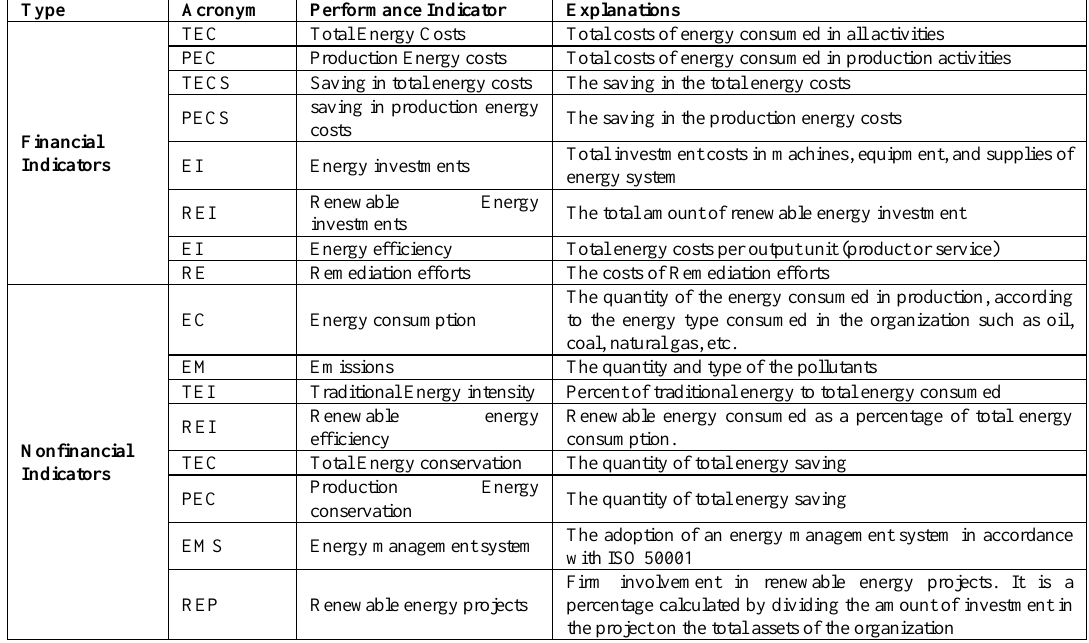
Table 3. Summary of performance indicators of sustainable